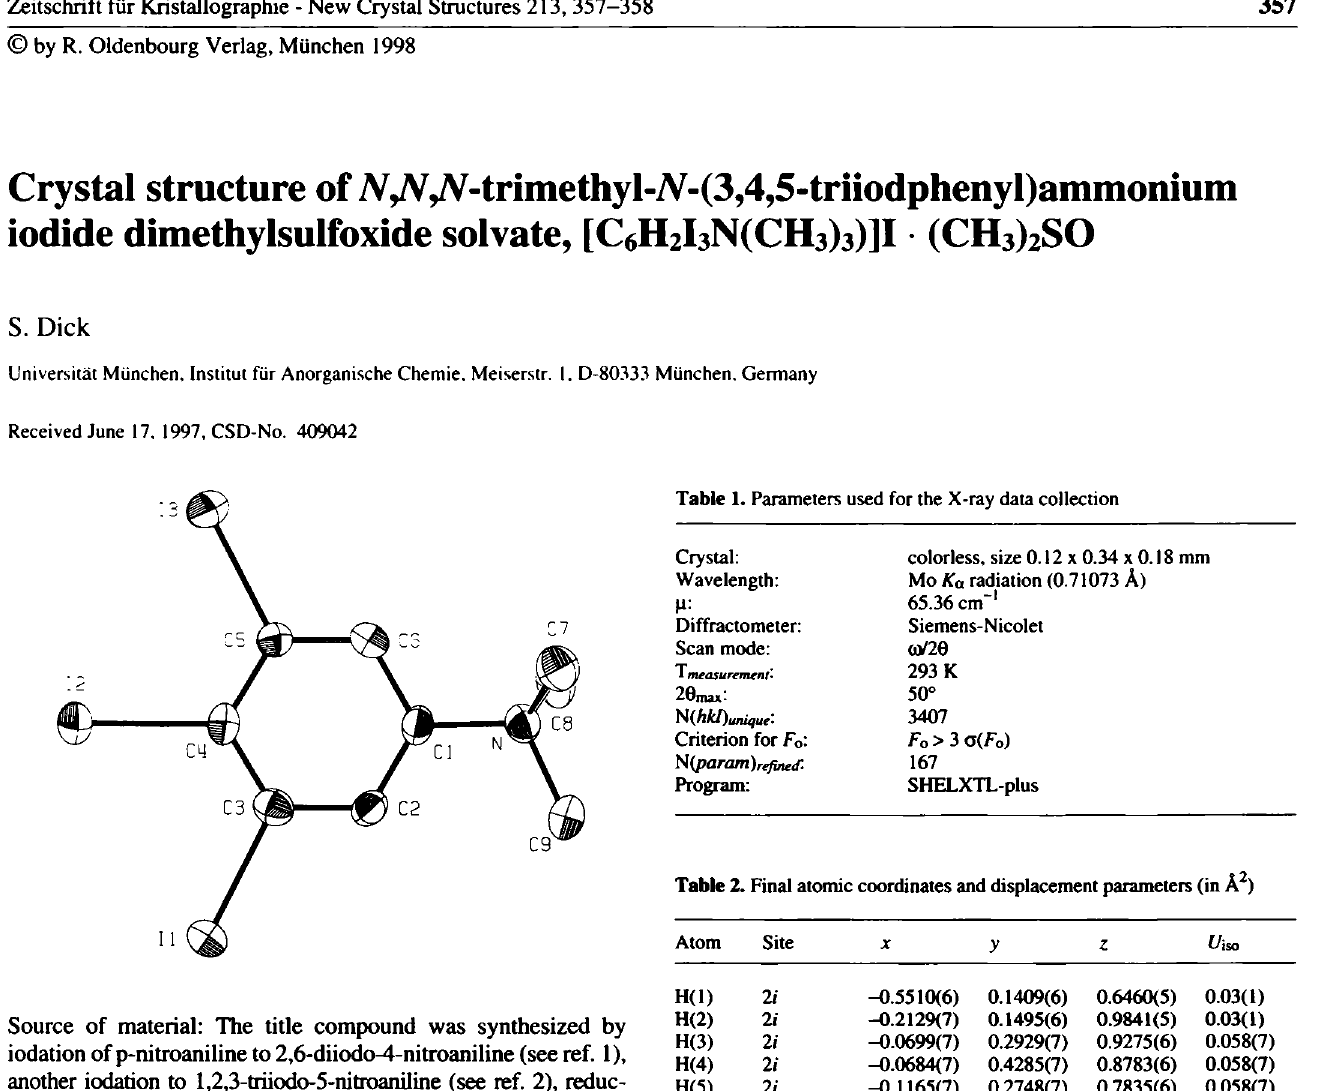
Source of material: The title compound was synthesized by iodation of p-nitroaniline to 2,6-diiodo-4-nitroaniline (see ref. 1), another iodation to l,2,3-triiodo-5-nitroaniline (see ref. 2), reduc- tion to 3,4,5-triiodoaniline (see ref. 3) and final methylation (see ref. 4). Slow diffusion of diethylether in a DMSO solution of the title compound yielded crystals with one molecule DMSO per formula unit.